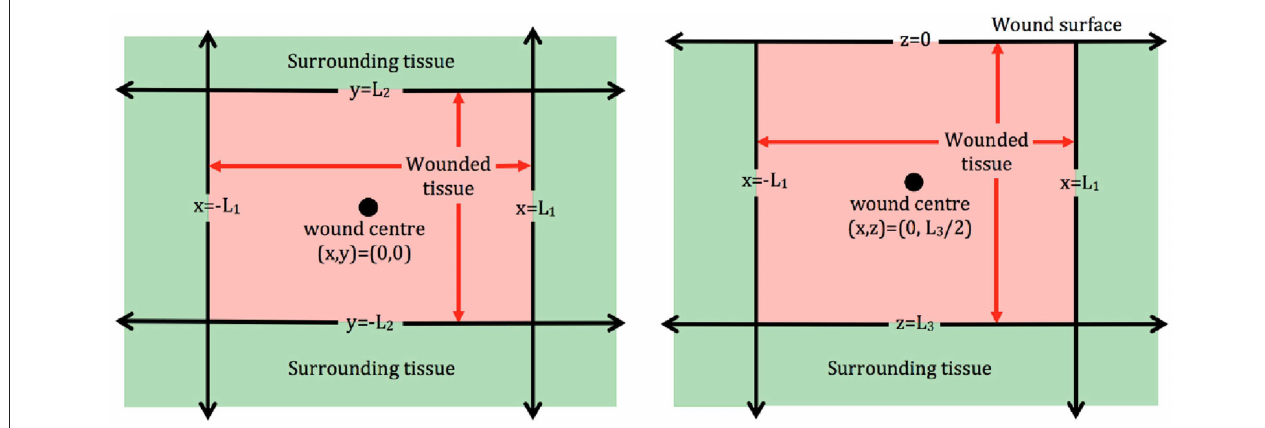
FIGURE 1 | Schematic of 2D wound domains. Left : Plan view of a rectangular wound that is parallel to the skin surface. Here x = − L 1 , x = L 1 , y = − L 2 , and y = L 2 represent the four wound edges. Right : Side view of a rectangular wound that is perpendicular to the skin surface. Here x = − L 1 and x = L 1 represent the wound extent parallel to the surface, which is located at z = 0 , and the wound depth is z = L 3